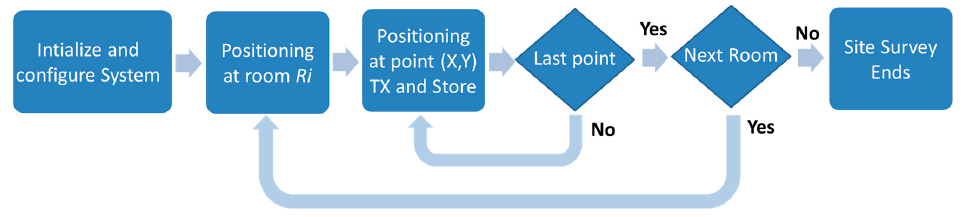
Figure 4. Site survey process flowchart.